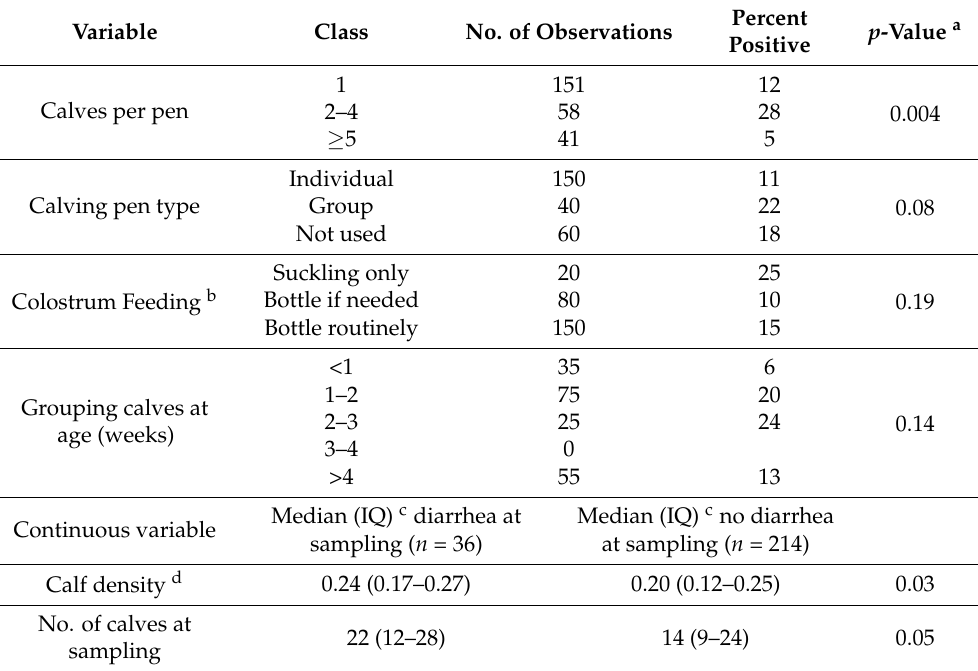
Table 4. Factors univariably associated ( p < 0.2) with diarrhea (Yes/No) in 250 preweaned calves and offered to the multivariable regression model.